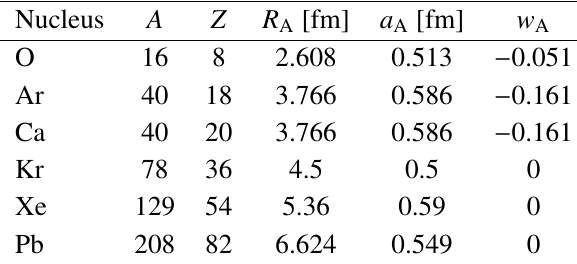
Table 3 . Parameters of the Woods-Saxon profile, eq. (3.8), for a variety of nuclei implemented in our code. For each ion we quote its mass number, charge, and radial parameters R A , a A , and w A from refs. [97, 110,